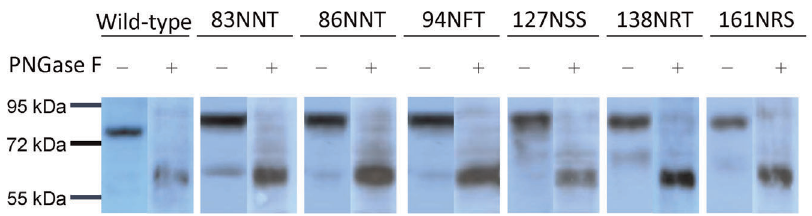
Figure 6. Hyperglycosylated HA characterization. Cell lysates from 293 cells transfected with hyperglycosylated DNA-HA vectors were treated with PNGase F to determine changes in HA molecular weights. HA mutant proteins expressed by the DNA-HA vectors with added N-linked glycans (83NNT, 86NNT, 94NFT, 127NSS, 138NRT and 161NRS) all had increased molecular weights that decreased following PNGase F treatment.